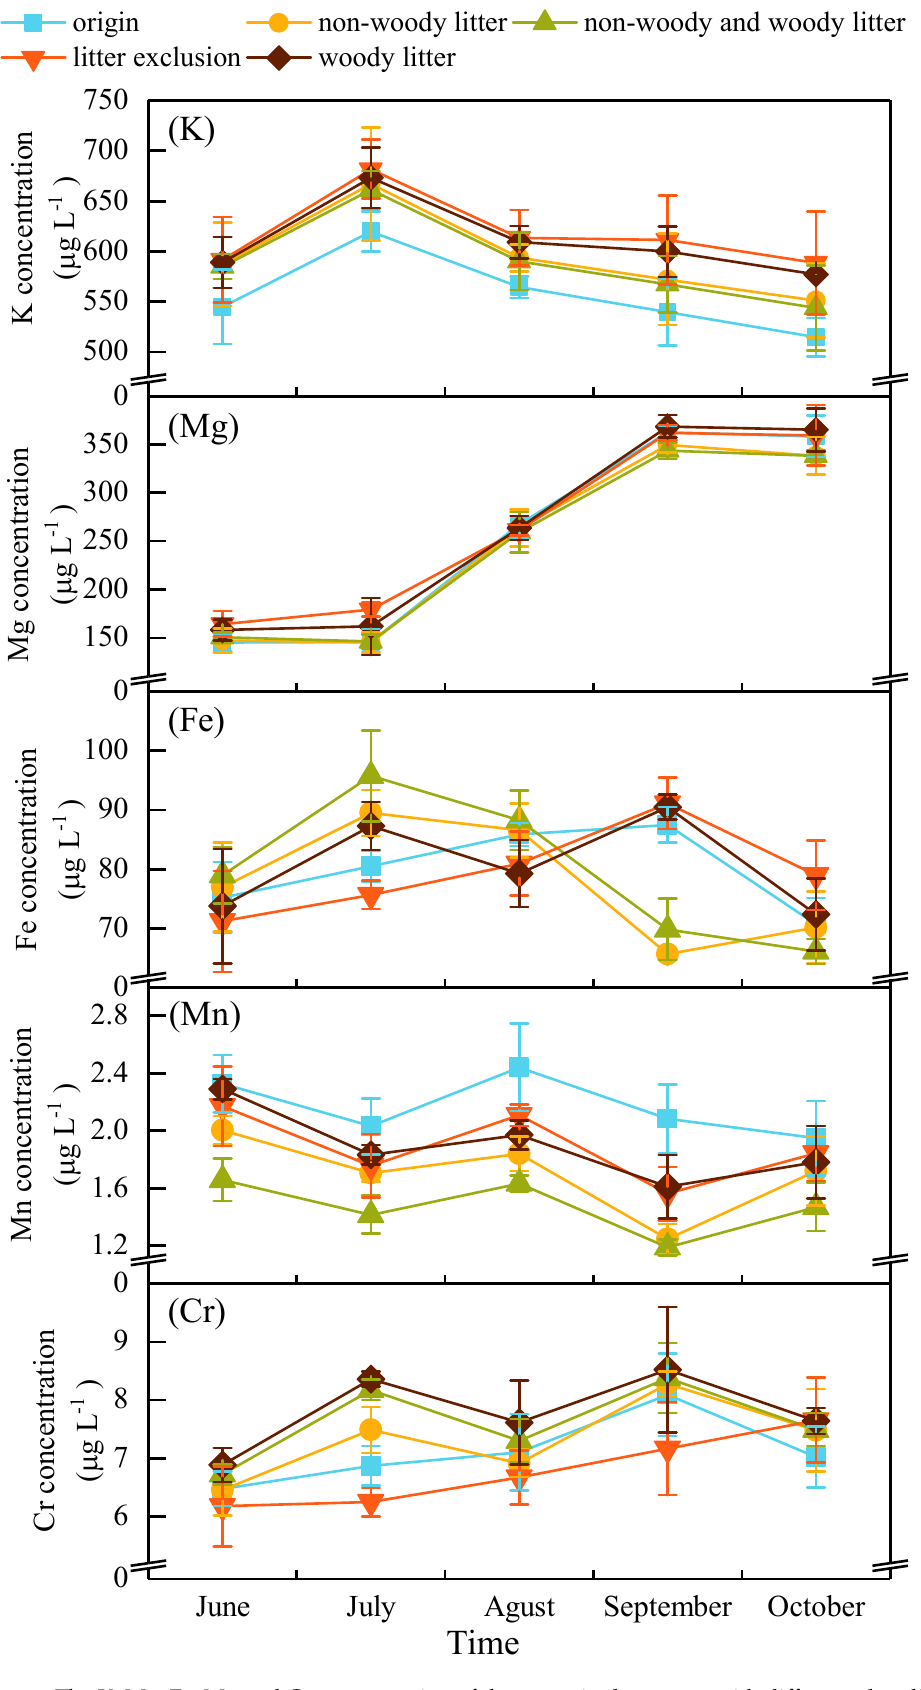
Figure 2. The K, Mg, Fe, Mn and Cr concentration of the water in the stream with different plant litter input conditions.